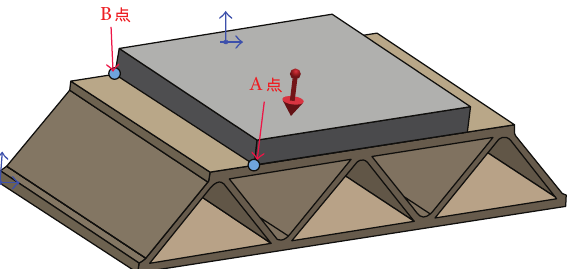
Figure 13: The drop test model with different flute